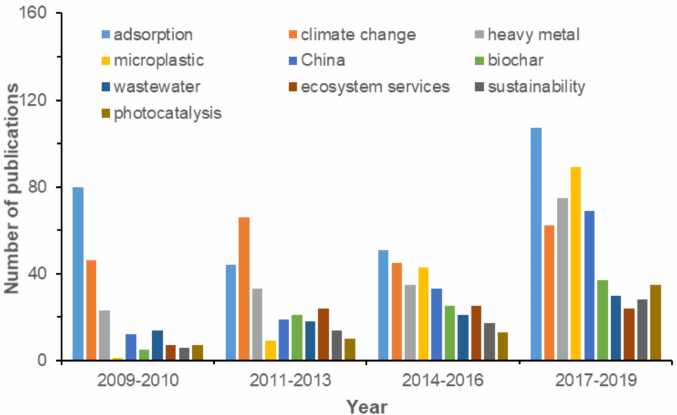
Figure 4. Top 10 high-frequency keywords of HCPs in the environmental sciences